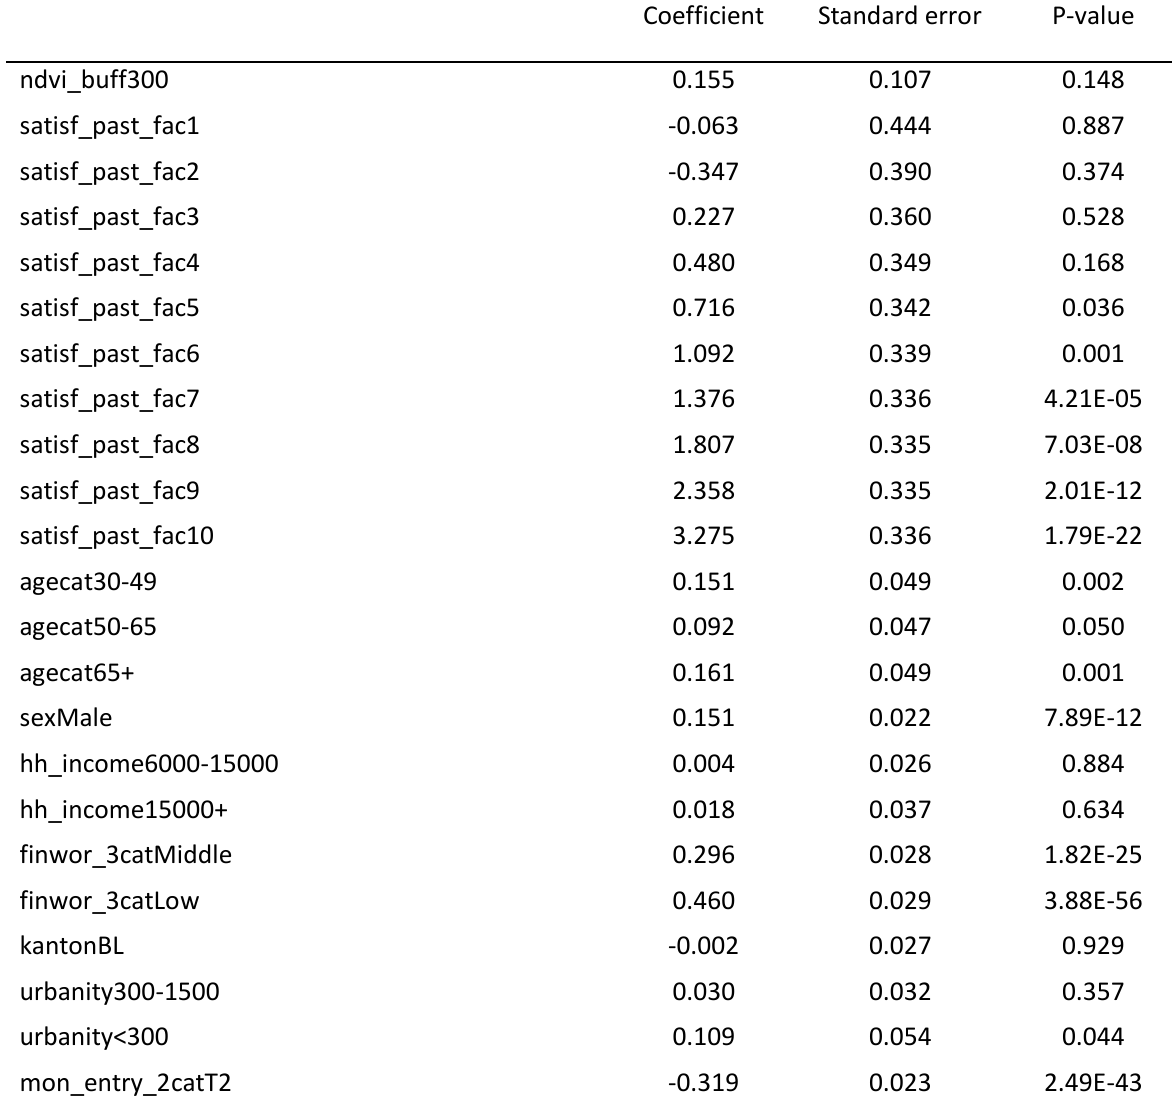
Table S4 . Results from ordered probit regression of life satisfaction on NDVI adjusted for life satisfaction in the past, age categories, sex, household income, financial worries, canton, degree of urbanisation, and month of